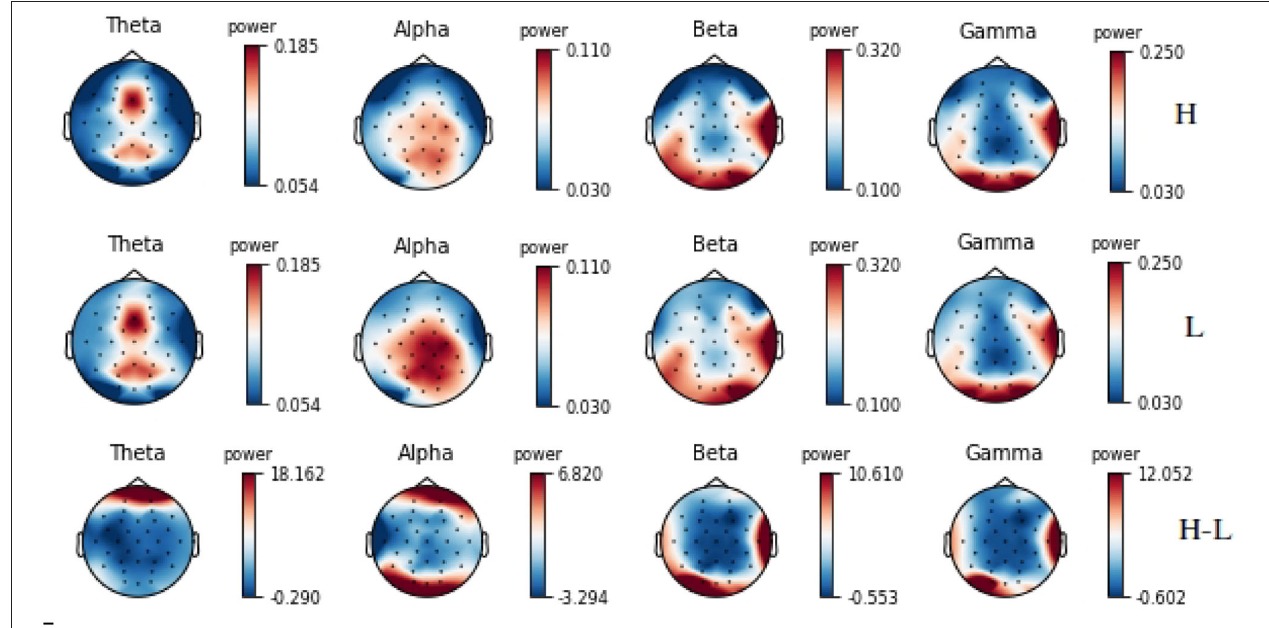
FIGURE 10 | Topographic maps of the average power across subjects in the θ , α , β , and γ bands for the high and low mental workload conditions, and their difference (“H”: high workload; “L”: low workload; “H-L”: difference between high and low workload).